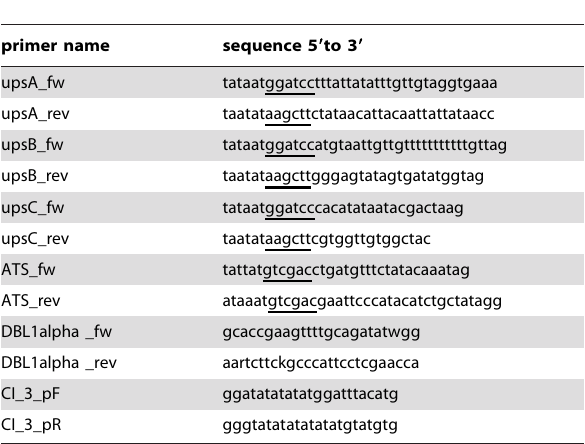
Table 1. Primers used for targeting, screening, sequencing, and gap